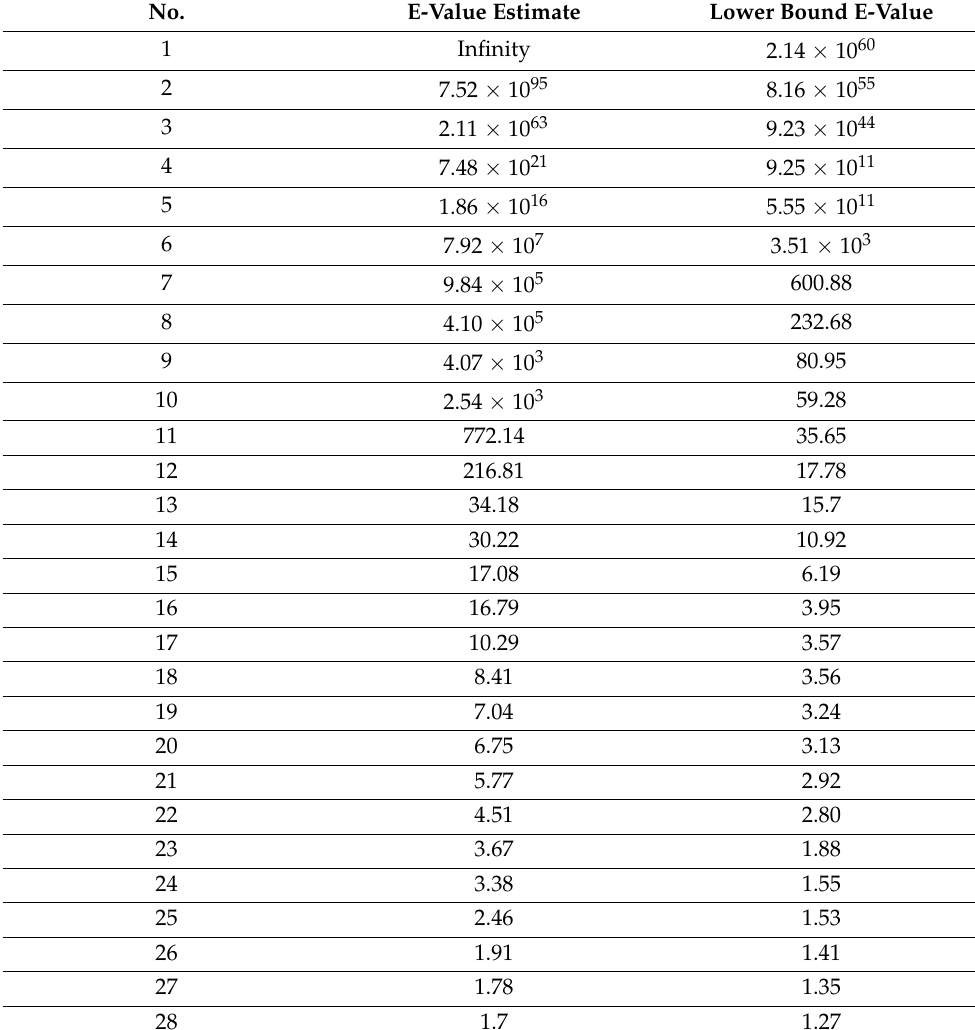
Table 8. Sequential List of E-Values. No. E-Value Estimate Lower Bound E-Value 1